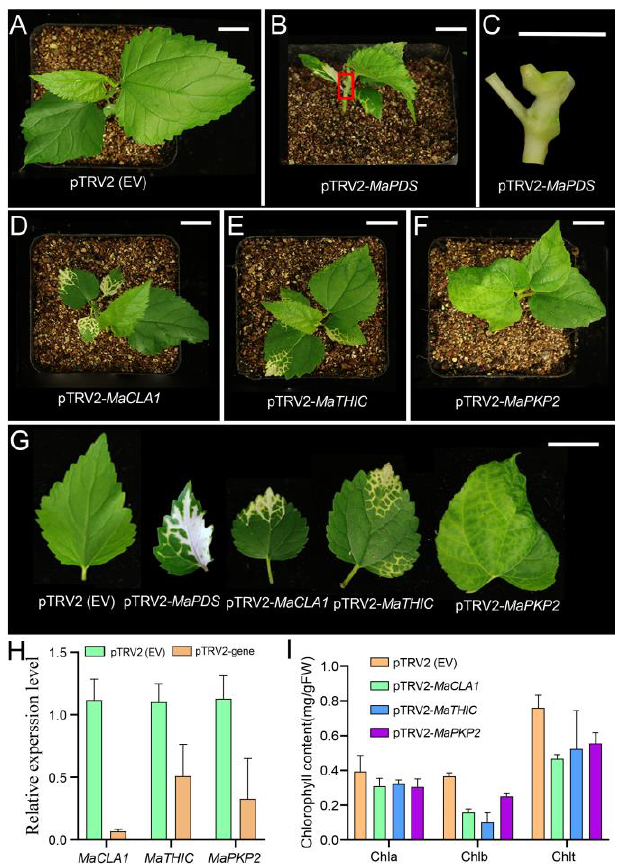
Figure 5. Virus-induced gene silencing (VIGS) of MaCLA1 , MaTHIC , and MaPKP2 in mulberry. ( A ) pTRV2 (EV) plant as negative control; ( B ) VIGS plant of MaPDS as positive control; ( C ) The stem of the enlarged map for the red box in ( B , D ) VIGS plant of MaCLA1 ; ( E ) MaTHIC VIGS plant; ( F ) VIGS plant of MaPKP2 ; ( G ) leaf phenotype of VIGS plant; Scale bar, 1 cm. ( H ) Relative expression of MaCLA1 , MaTHIC , and MaPKP2 ; ( I ) Chlorophyll contents of the chlorotic leaves from VIGS plants. Error bars indicate the standard deviation (n = 2). Chla: chlorophyll a, Chlb: chlorophyll b, Chlt: total chlorophyll.